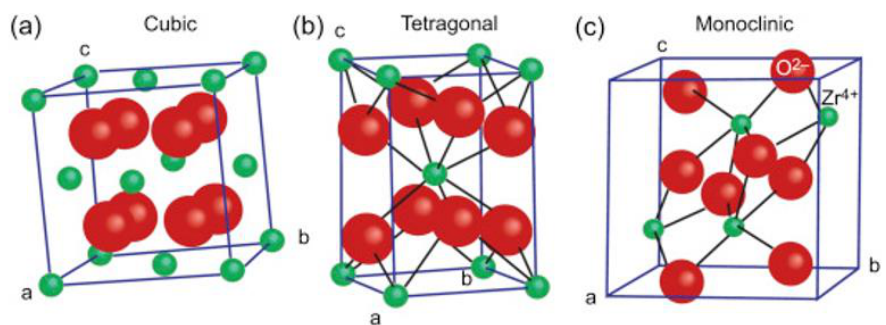
Figure 5. ( a – c ) Crystal structures and crystallographic information for monoclinic, tetragonal, and cu- bic phases in ZrO 2 , respectively [63] (reproduced with permission number: 5055990208243,